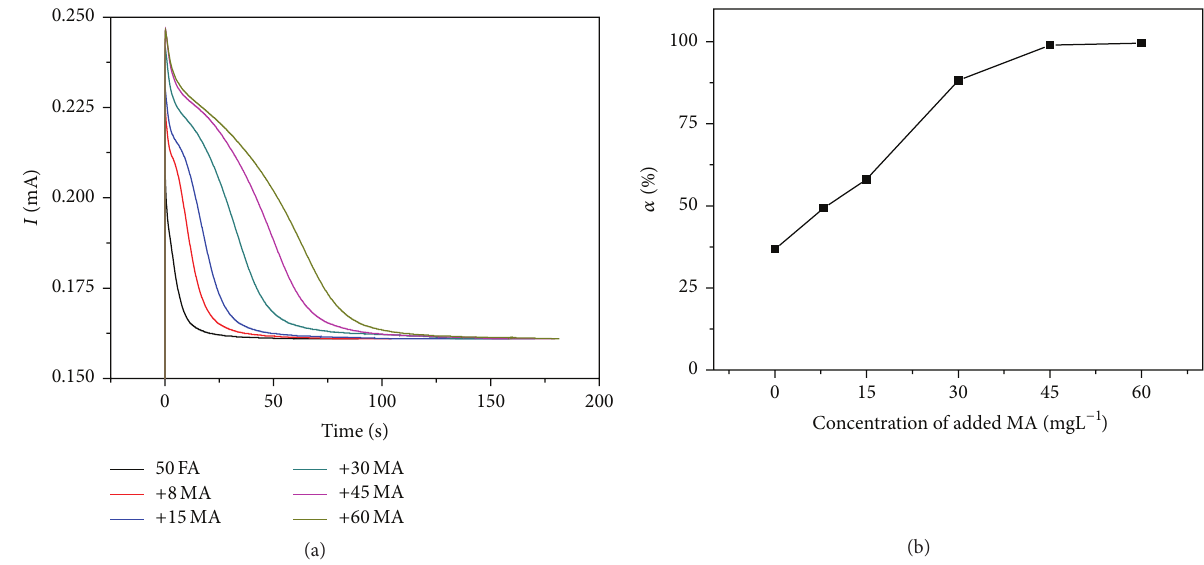
Figure 6: The (a) photocurrent-time signals and (b) degradation rate of FA added MA.